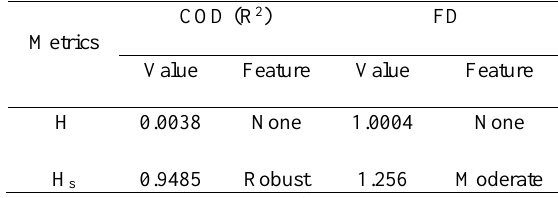
Table 2. The CODs and FDs of Shannon diversity index and Spatial Entropy